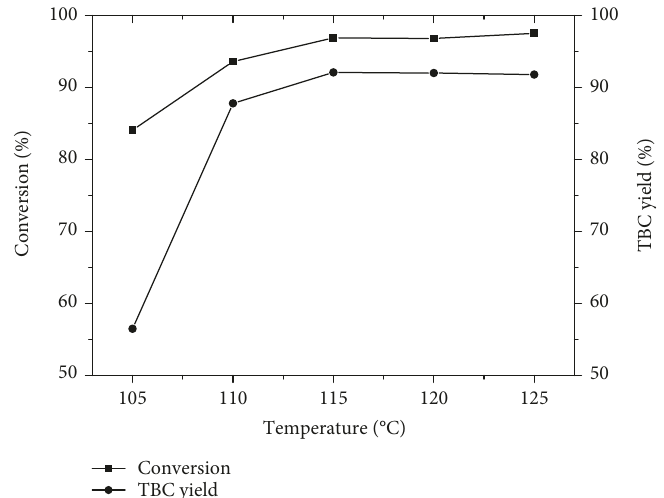
Figure 3: E ff ect of the reaction temperature on the esteri fi cation of citric acid with n-butanol. Reaction conditions: citric acid, 0.06mol; n-butanol, 0.3mol; catalyst, 6wt%; time, 5h.